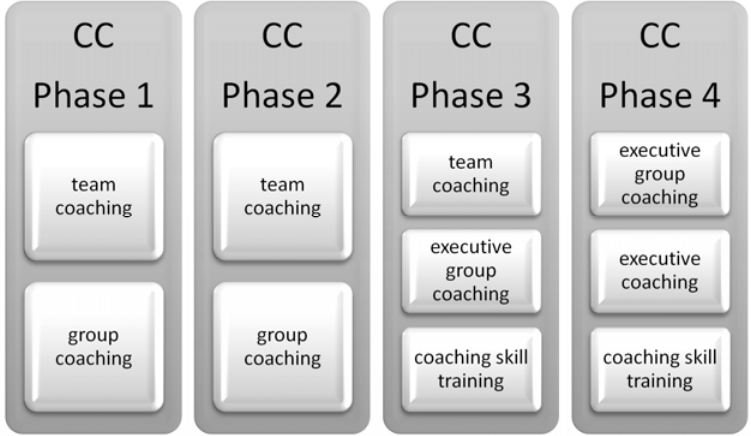
Fig. 4. Implications for organizations regarding developing coaching culture: what kind of outside support to use? Notes: team coaching – participants are the team-leader and team-members; group coaching – participants are the members of the organization (e.g., group of team-leaders, group of specialists